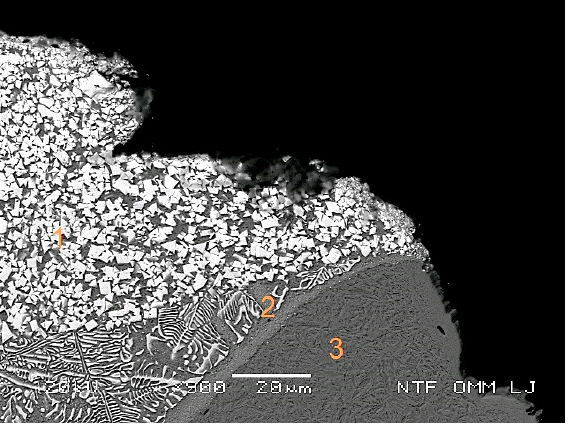
Figure 18. Display of tooth steel material: 1—carbide coating, 2—mixed zone, 3—tooth steel (body).